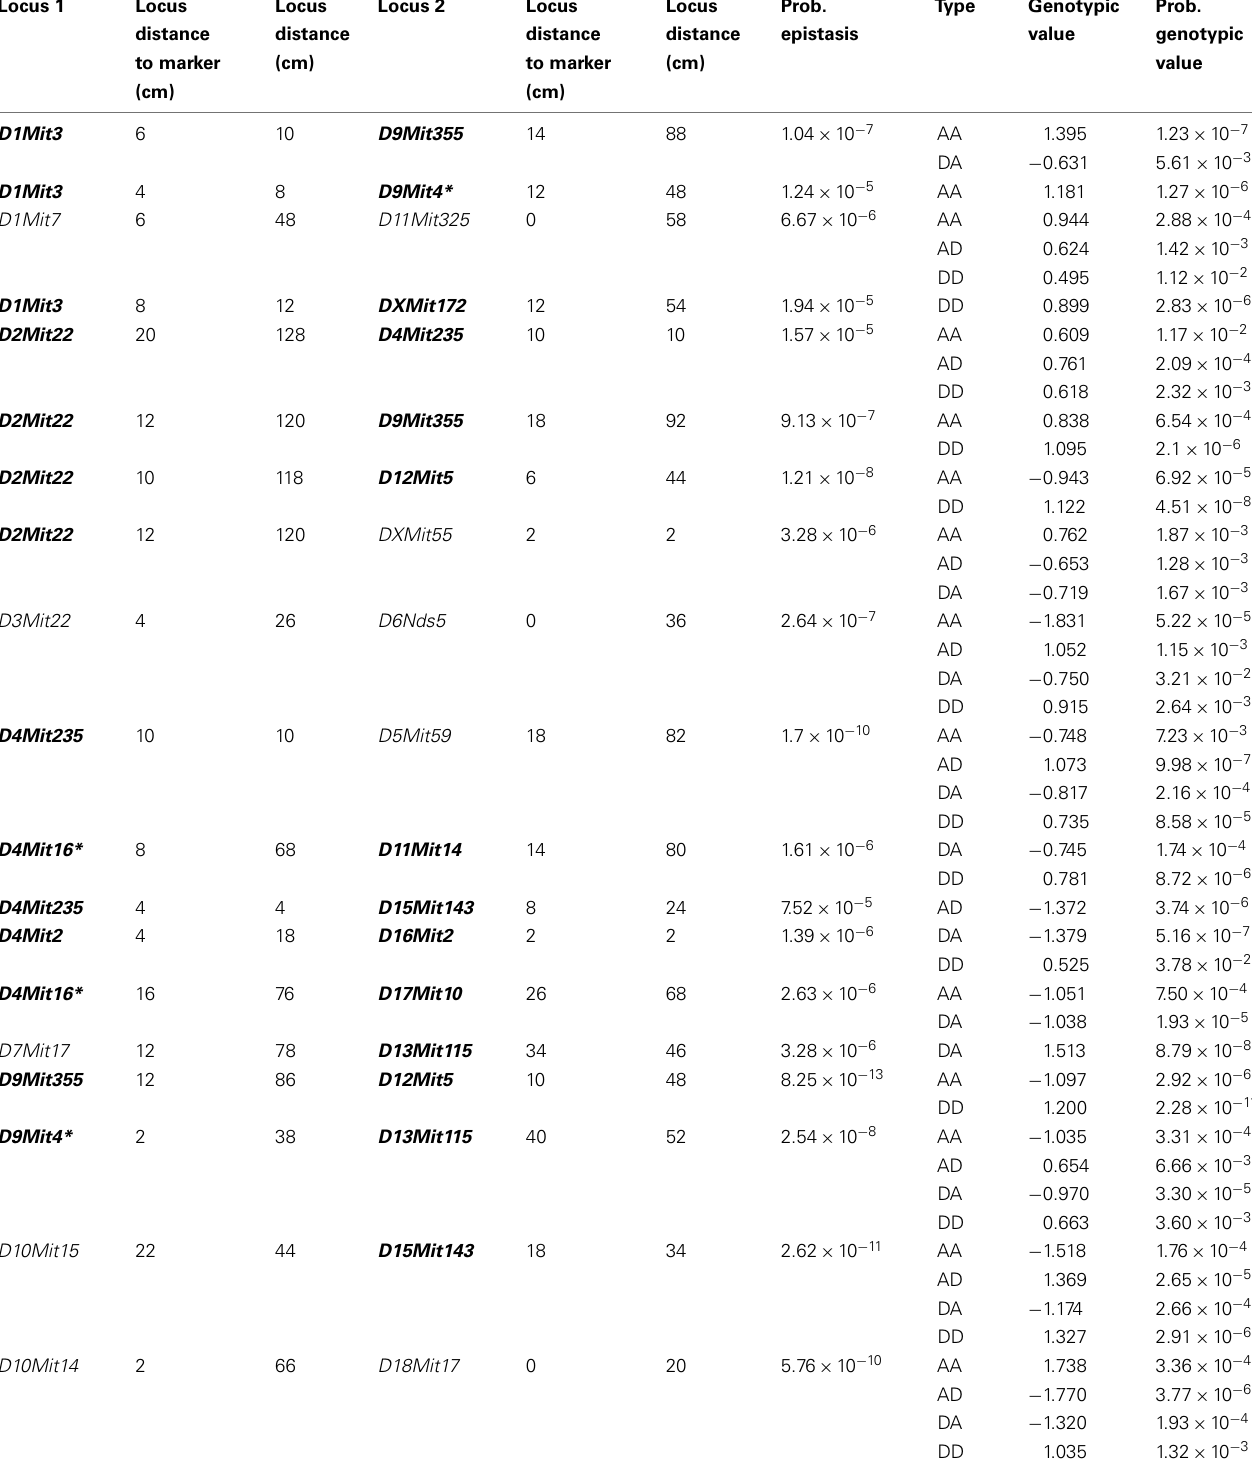
TableA4 | Epistatic QTLs of postpartum nest presence in F 2 . Prob. Type Locus Locus 2 Locus Locus Locus 1 Locus distance distance distance distance